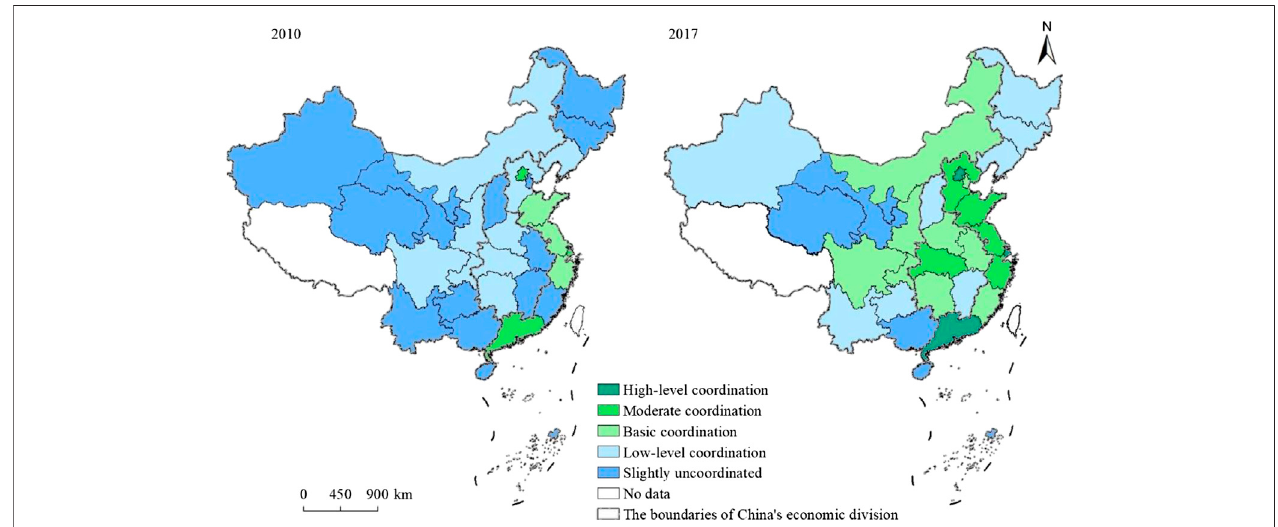
FIGURE 6 | Spatial distribution of coupling coordination degree during 2010 –